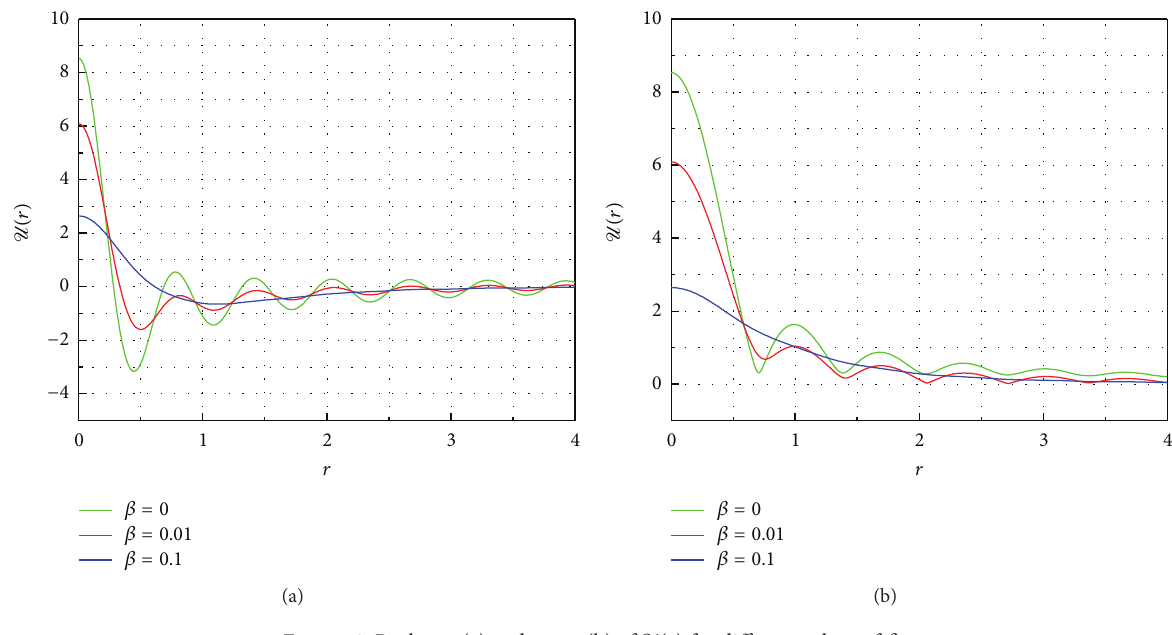
Figure 3: Real part (a) and norm (b) of U (𝑟) for different values of 𝛽